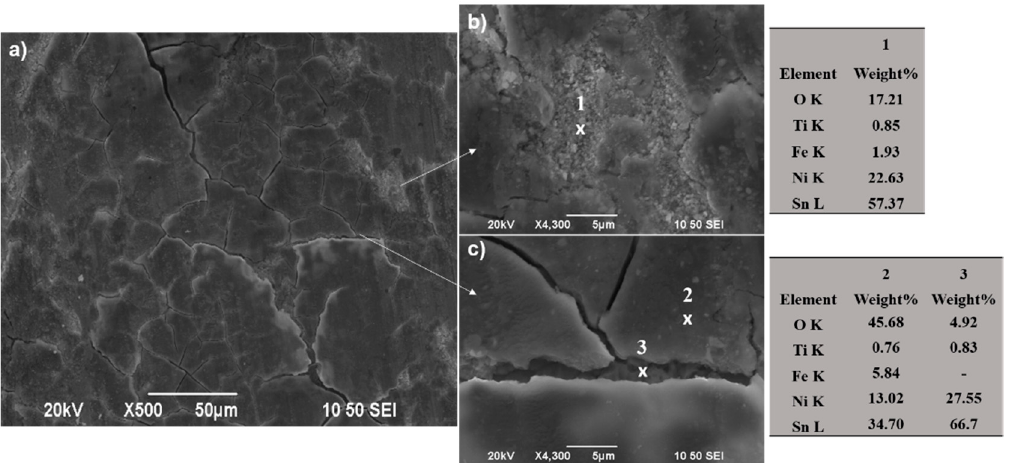
Figure 17. ( a ) Representative SEM surface micrograph inside the wear track of composite SnNi/co- doped N,S-TiO 2 electrodeposit (Sample B). ( b , c ) Corresponding SEM surface micrograph at higher magnifications and corresponding spot EDS analysis: Spectrum 1 in image ( b ) and Spectrum 2, 3 in image ( c